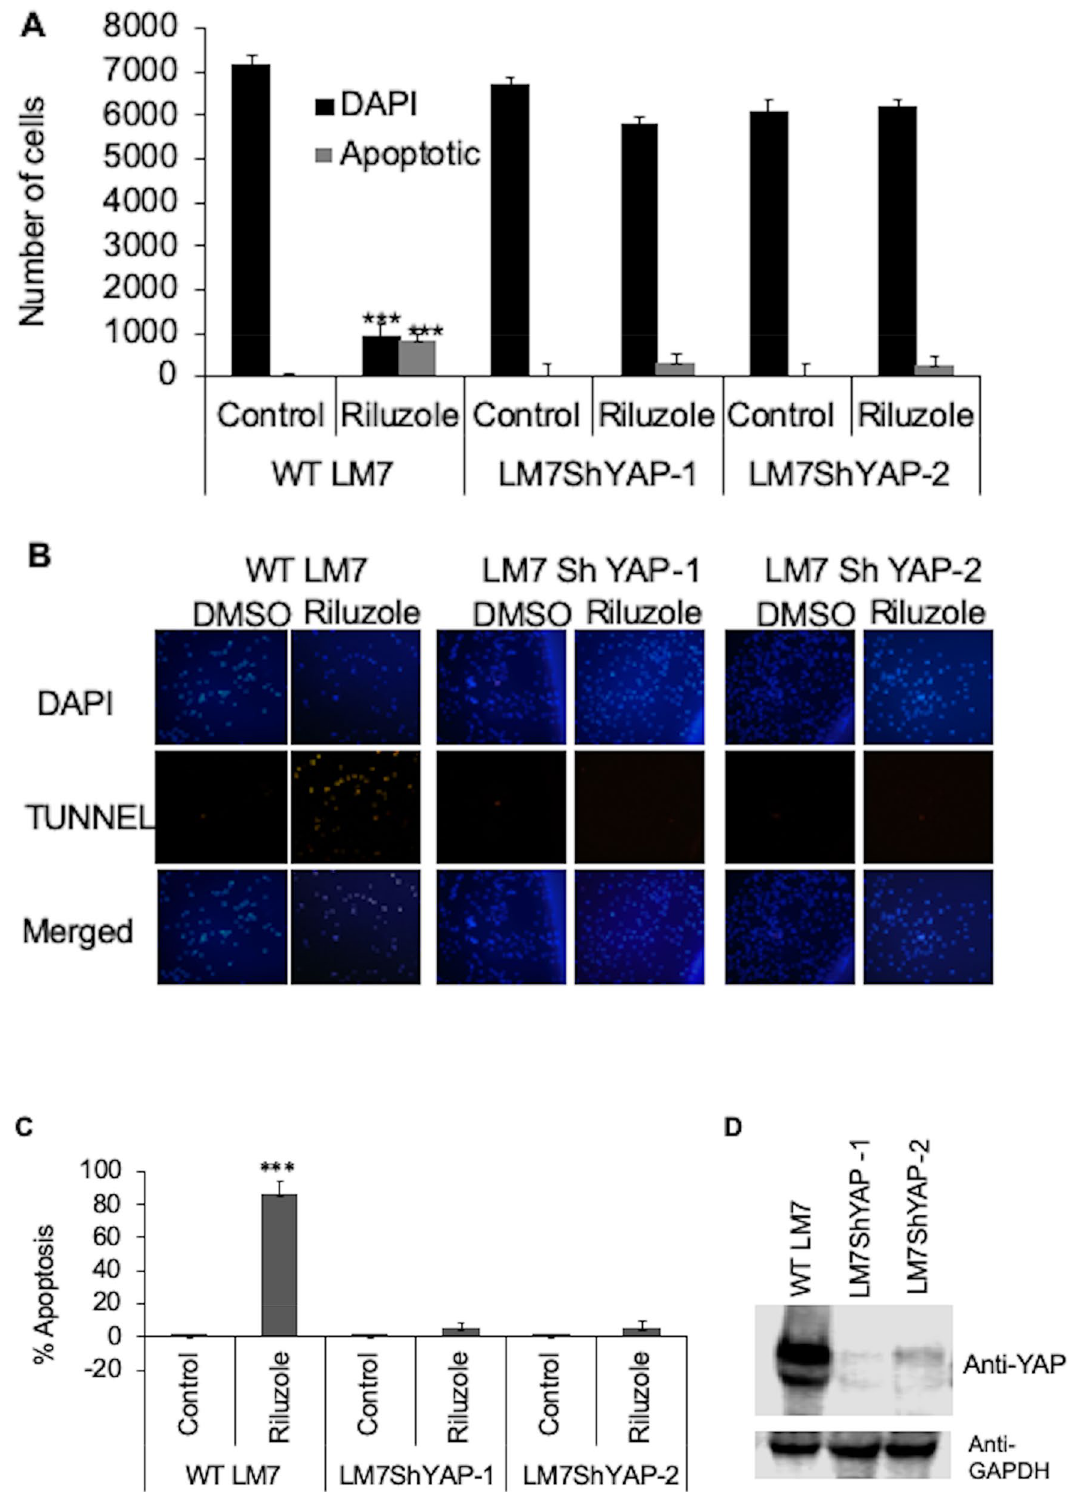
Figure 1. YAP knockdown decreases Riluzole induced apoptosis in LM7 cells. ( A ) Apoptosis in WT LM7 cells with control shRNA or LM7shYAP-1and LM7shYAP-2 with shYAP were treated with Riluzole (100 μM) or DMSO for control. DAPI positive and TUNEL positive cells were scored by fluorescence microscopy. Triplicate samples were analyzed for each treatment. The experiment was repeated three times, p value ***< 0.001. ( B ) Representative images of TUNEL assay are shown. ( C ) Percentage of apoptotic cells was analyzed based on the number of DAPI positive and TUNEL positive cells. ( D ) Western blot of YAP expression in WT LM7 cells and LM7shYAP cells using mouse anti-YAP antibody and reprobed with rabbit anti-GAPDH as a loading